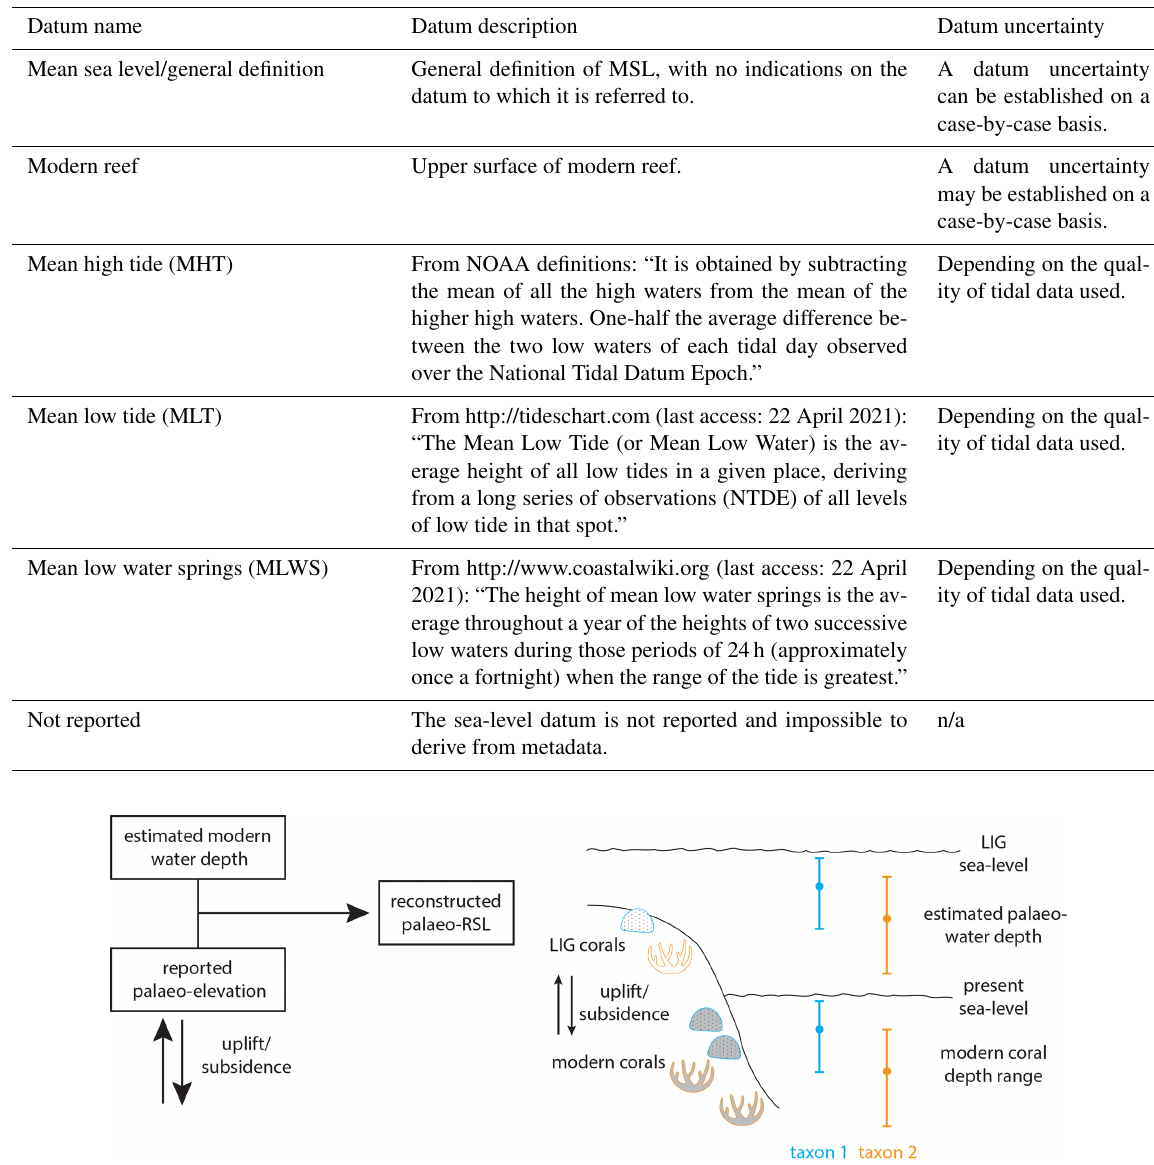
Table 4. Sea-level datums reviewed in this study. n/a – not applicable